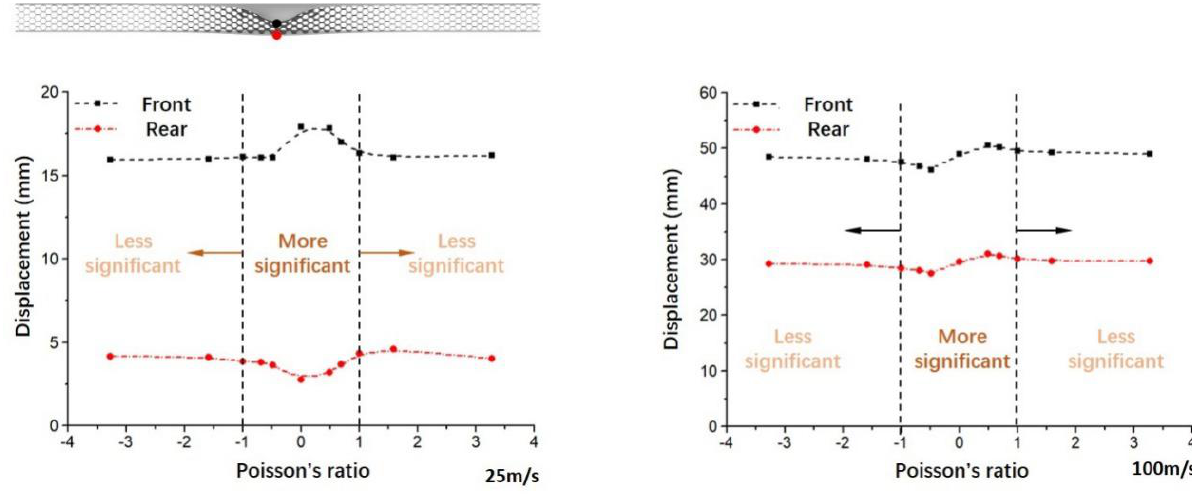
Figure 10: Maximum displacement of front and rear face-sheet.